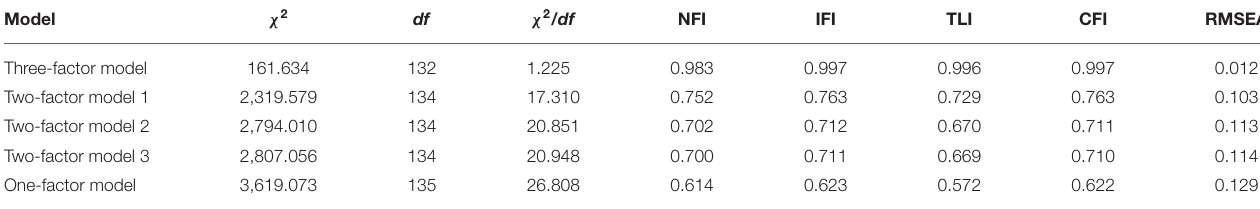
TABLE 2 | Fitting indexes of competition models ( N = 1,548). Model χ 2 df χ 2 /df NFI IFI